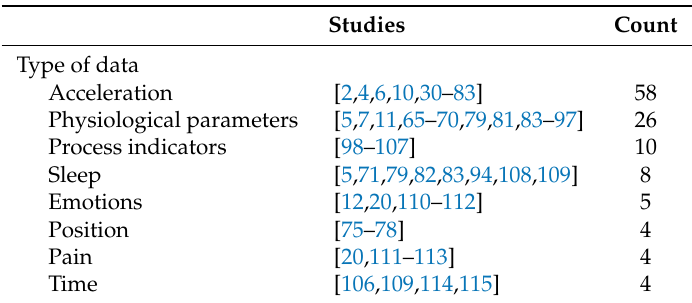
Table 2. Data used for health monitoring of older